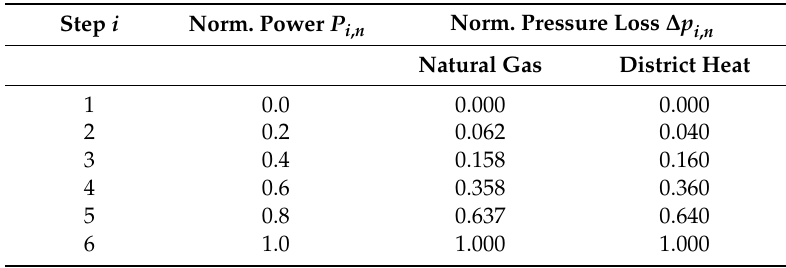
Table A2. Normalised power and pressure loss.